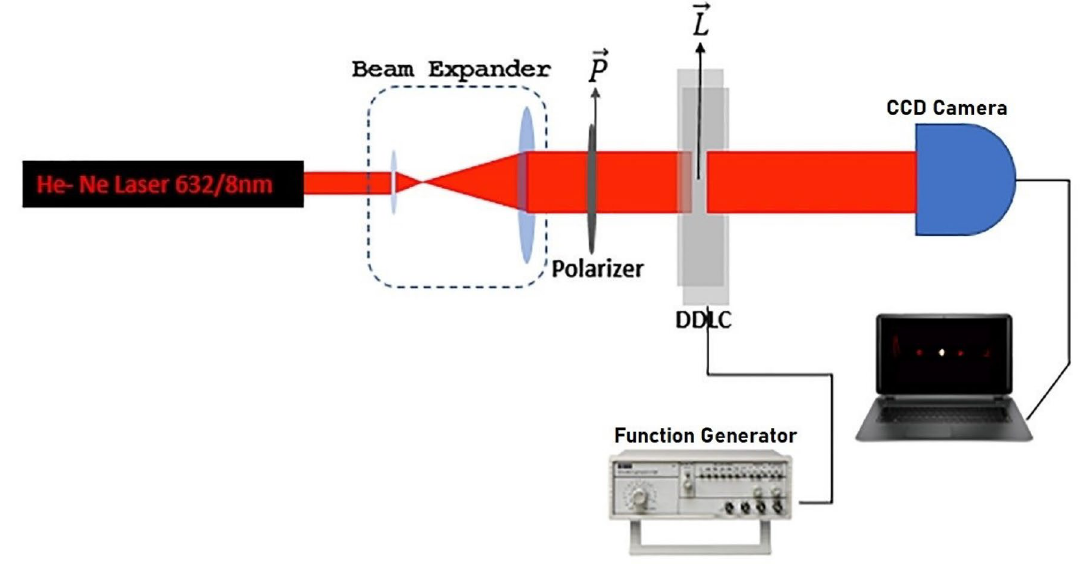
Figure 7. The schematic of vortex beam generation by using DDLC cell.